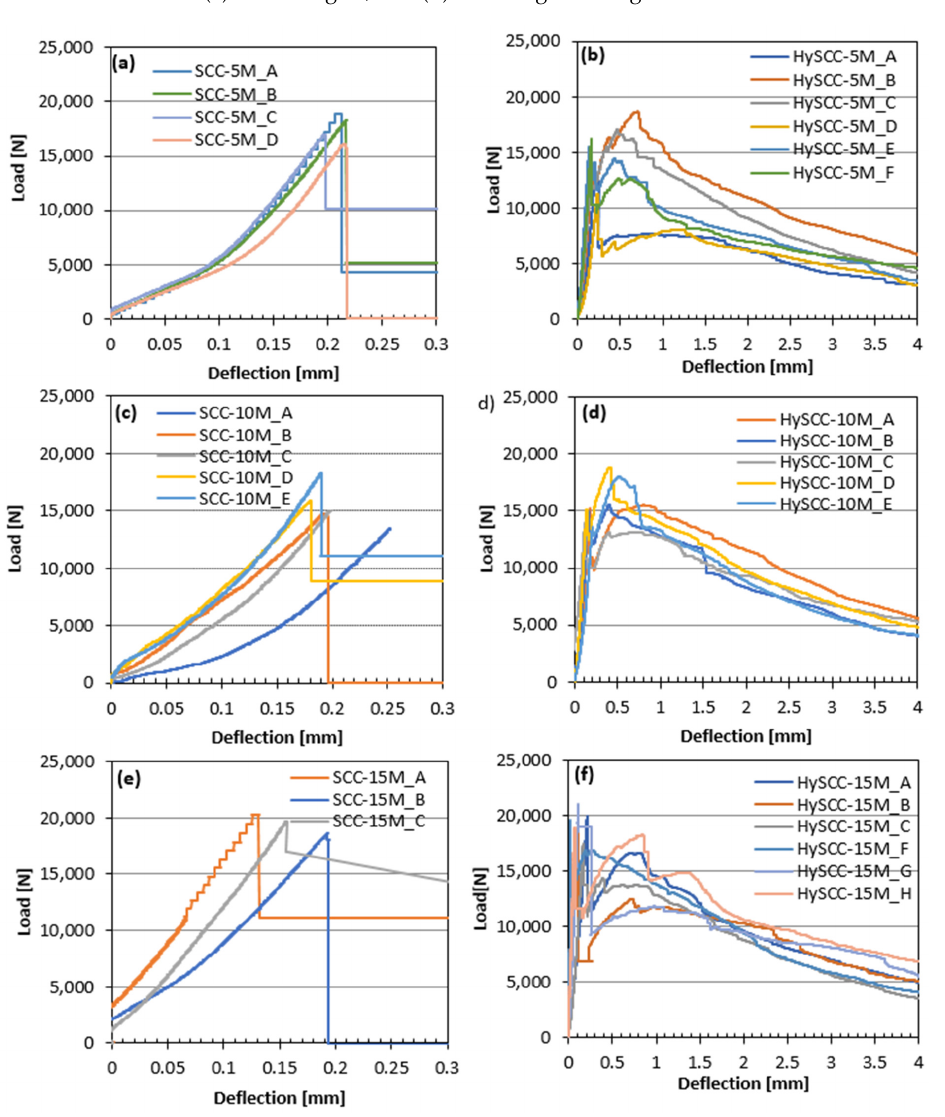
Figure 5. Load–deflection curves for: ( a ) SCC-5M without fibers, ( b ), HySCC-5M with fibers ( c ), SCC-10M without fibers ( d ), HySCC-10M with fibers ( e ), and SCC-15M without fibers ( f ) HySCC-15M with fibers.